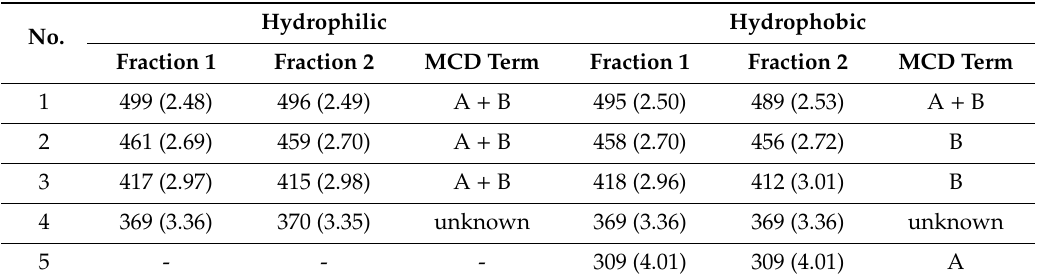
Table 1. Transition positions in nm (eV), type of magnetic circular dichroism term. Hydrophilic No.